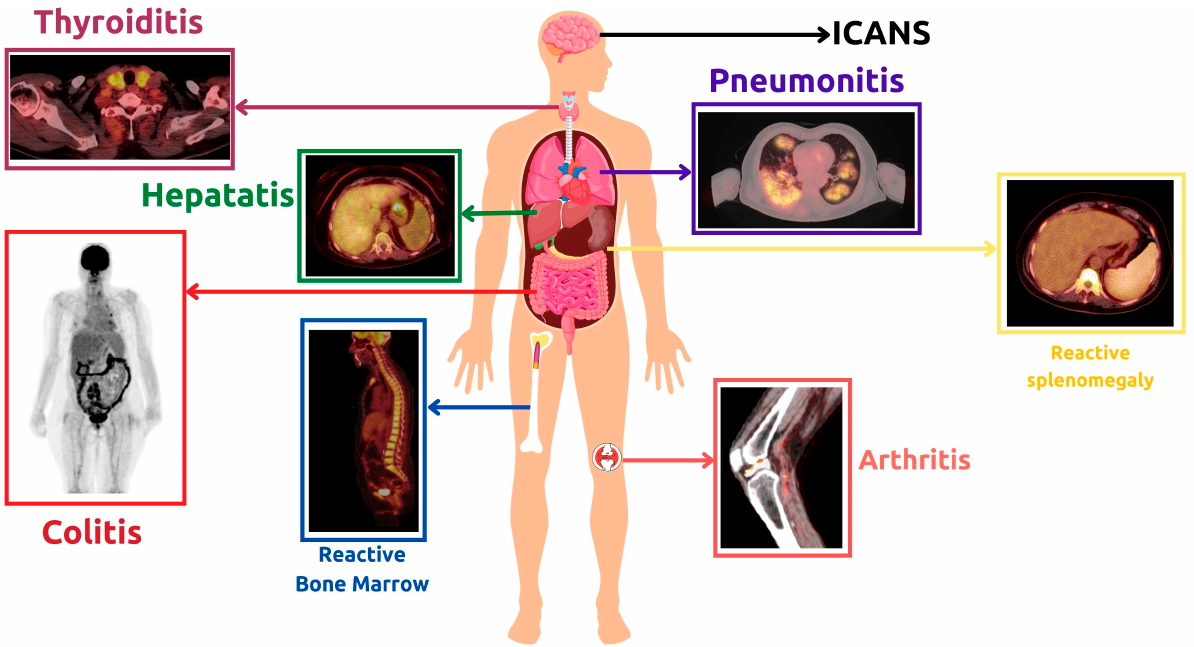
Figure 8. Clinical examples of Immunotherapy-Related Adverse Effects observed during FDG PET/CT imaging in lymphoma patients receiving immunotherapy.